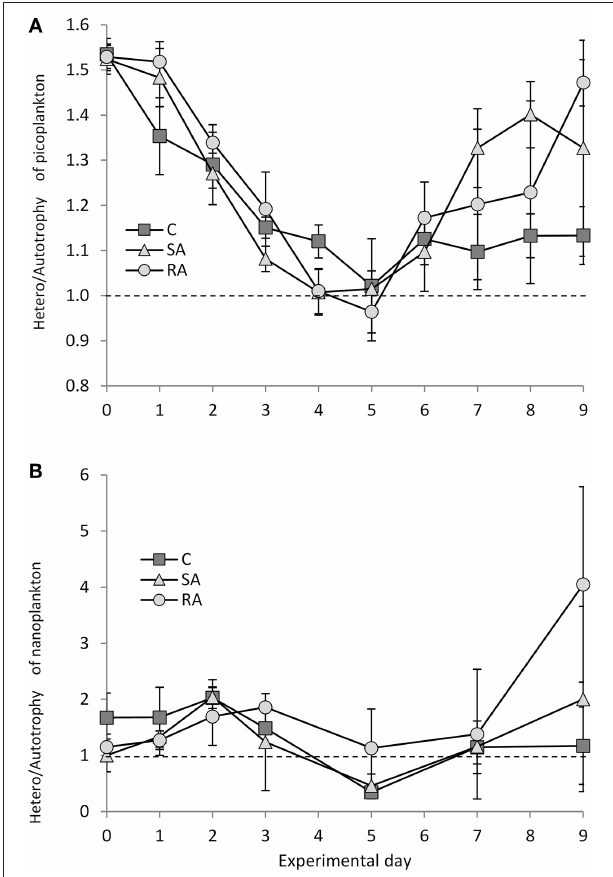
FIGURE 8 | Ratio of heterotrophic to autotrophic biomass for (A) pico-plankton and (B) nano-plankton during the mesocosm experiment. Cnt = Control mesocosms (no addition), SA = single addition, mesocosms where dust was added once, on the first day of the experiment, RA = repetitive addition, mesocosms where the same quantity of dust was added, divided in three doses, on the first 3 days of the experiment, Days 0, 1, and 2. Data are mean ± SD of three replicates. Dashed line indicates balance between autotrophic and heterotrophic